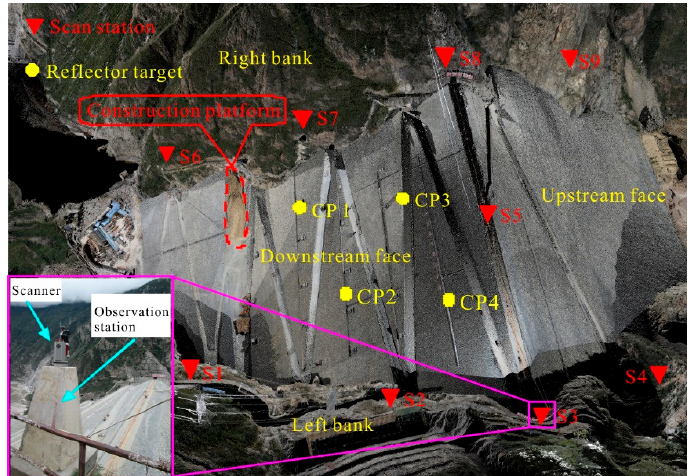
Figure 4. Aligned 3D model of the Changhheba dam (rendered view).